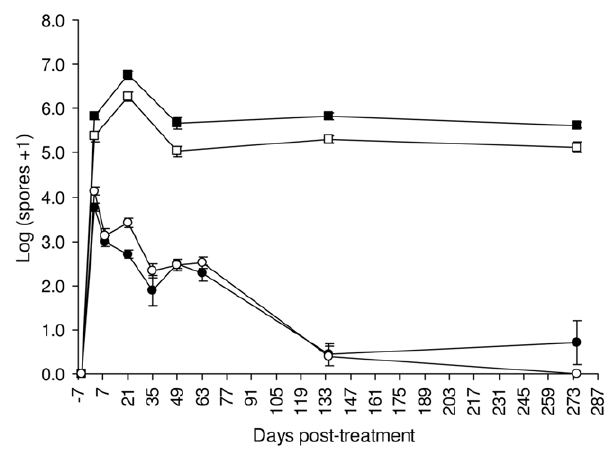
Figure 2. Evolution of Lysinibacillus sphaericus and Bacillus thuringiensis israelensis spores in water and sludge samples N collected in treated catch basins (average ± SE). Symbols: # =Lsph spores per ml of water; =Bti spores per ml of water; % =Lsph spores per gram of sludge; & =Bti spores per gram of sludge.